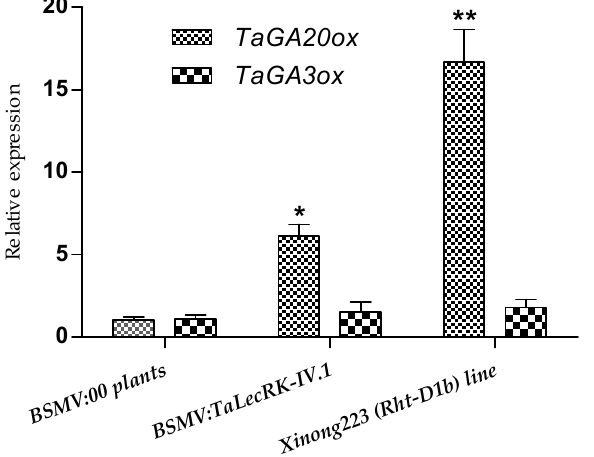
Figure 5. Expression of the dioxygenase genes ( TaGA20ox and TaGA3ox2 ) in CI12633 plants in- fected with BSMV:00 (control), BSMV: TaLecRK-IV.1 ( TaLecRK-IV.1 -silenced plants), and in Xinong223 ( Rht-D1b ) plants. The relative gene expression (comparative 2 −∆∆ C ) method was used and TaActin was considered as the reference gene to normalize the expression level of TaGA20ox and TaGA3ox2 . Asterisks indicate significant expression difference at 0.05 (*) or 0.01 (**) probability level as compared to the relative expression in control based on the Student’s t -test results.